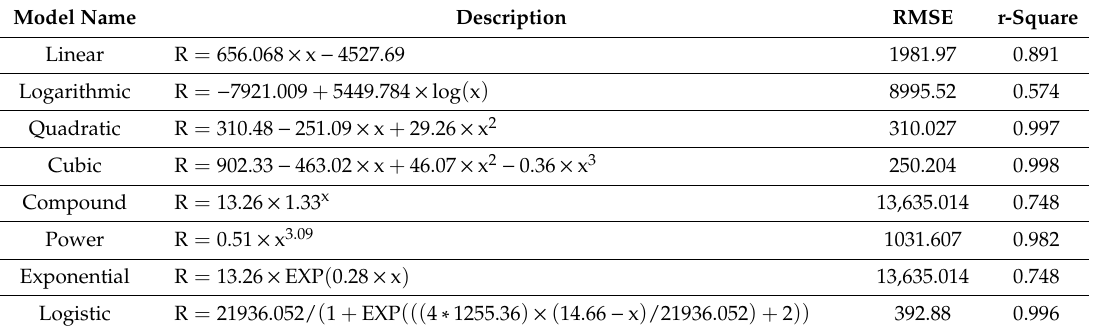
Table 13. Model description for Iran fitted by GWO.